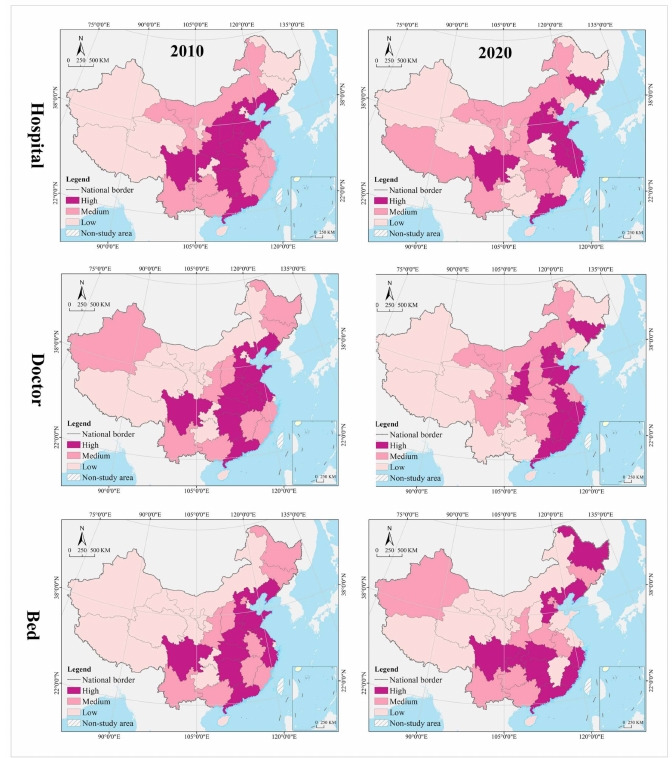
Figure 10. Spatial analysis of mismatch index contribution rate for